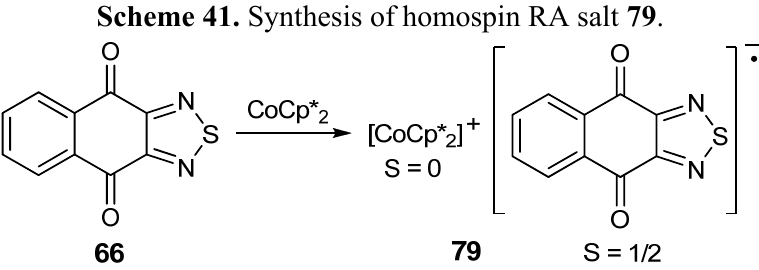
and CoCp , and two 2 2 ][ 66 ] ( 79 ) and [CoCp ] [ 66 ] ( 80 ), respectively, were isolated [99]. Analysis 2 2 2 3 Cl confirmed the complete CT with formation of the RA 2 2 Cl solution of salt 79 . 2 2 Scheme 41. Synthesis of homospin RA salt 79